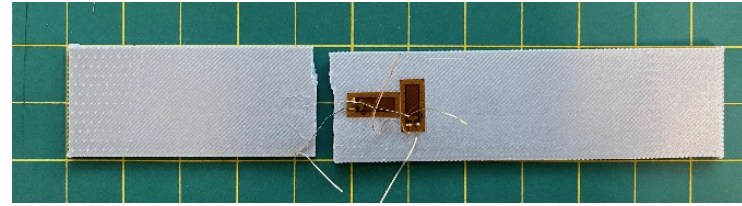
Figure 6. Post-test photograph of a specimen without a circular